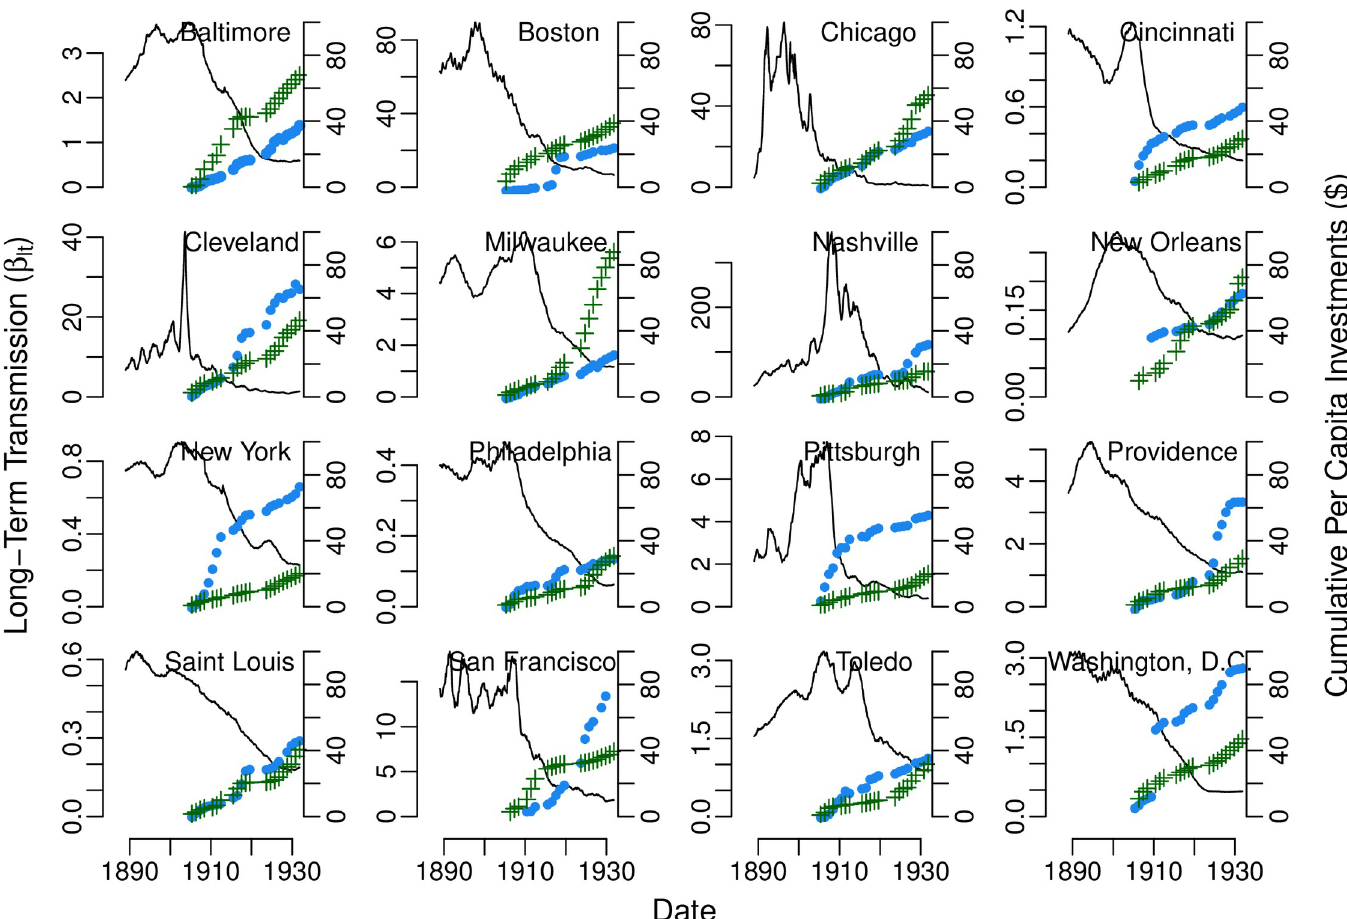
Fig 1. Annual seasonal typhoid transmission estimated from Time-series Susceptible-Infectious-Recovered models. The estimated seasonal transmission rate in each 4-week period is plotted for each city (color-coded by water source type; solid lines are the mean estimates and dashed lines are the 95% confidence intervals). The second- to-last panel shows the mean seasonal transmission across all cities in bold black. The last panel shows the mean seasonal transmission rate for cities with a particular water source type, with reservoirs in blue, rivers in green, and Great Lakes in purple. Seasons are shown in the background in shades of grey (medium-light grey for winter, light grey for spring, dark grey for summer, and medium-dark grey for